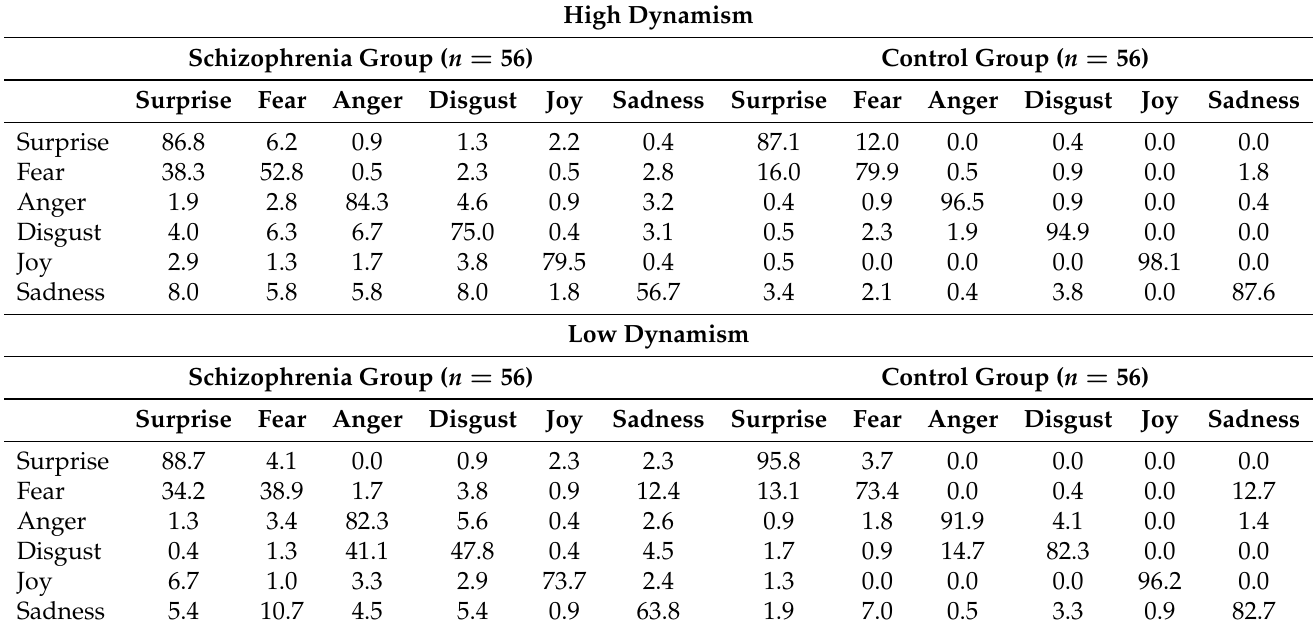
Table 4. Confusion matrix of emotion recognition (%) using high and low dynamism in DVFs when displaying emotions for the schizophrenia